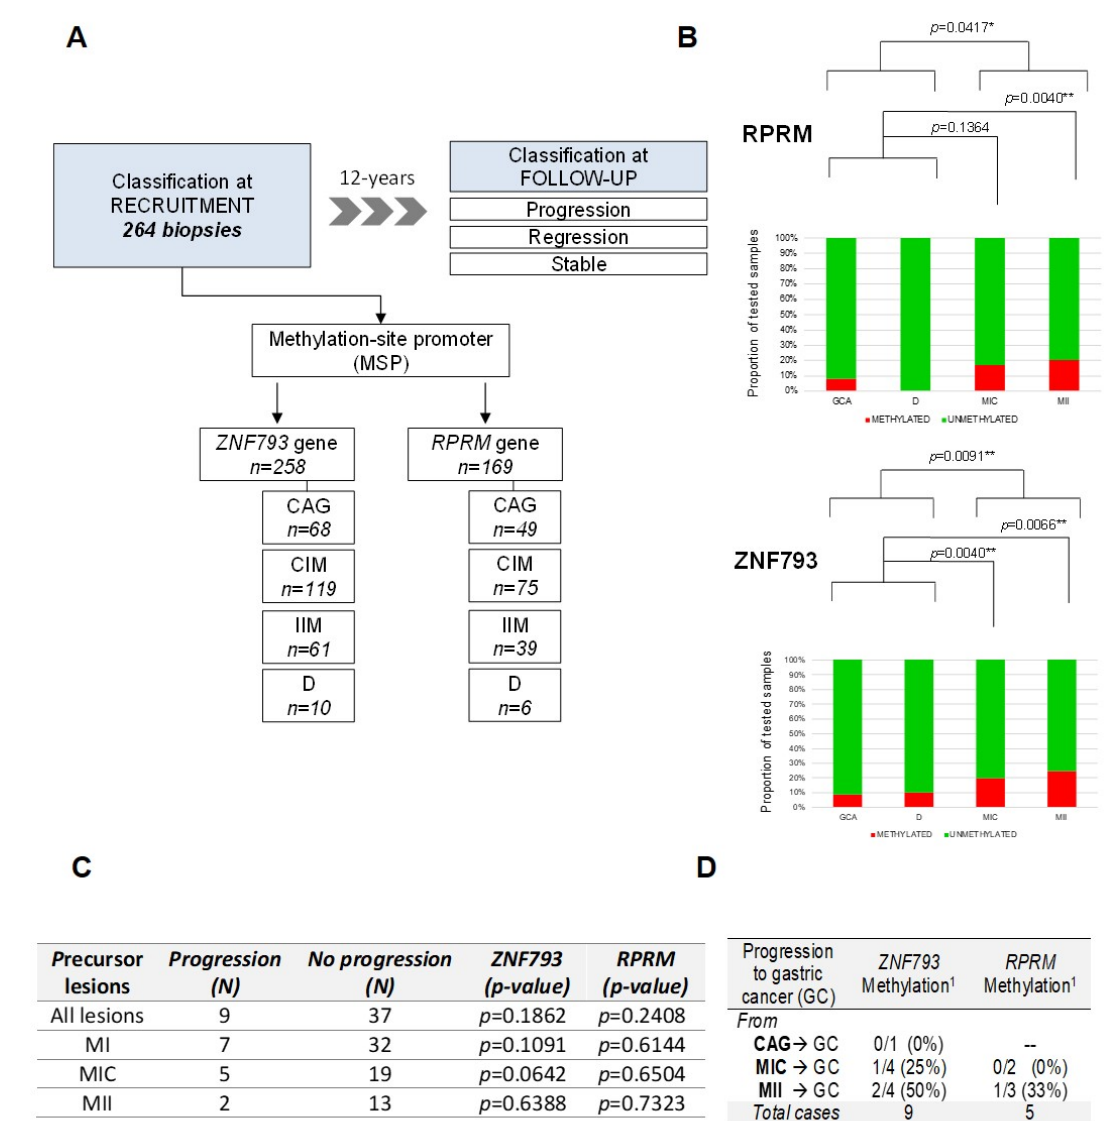
Figure 4. Methylation of ZNF793 and RPRM genes in a 12 ‐ year follow ‐ up study of gastric cancer precursor lesions. ( A ) Characteristics of the validation cohort of 264 samples corresponding to precursor lesions obtained from an observational longitudinal study. ( B ) Methylation events for ZNF793 ( up ) and RPRM ( down ) genes in precursor lesions. (* p ‐ value ≤ 0.05, ** p ‐ value ≤ 0.01) ( C ) Association analysis between the progression in the cascade of gastric precursor lesions and the methylation of ZNF793 and RPRM genes. The p ‐ values are obtained from Fisher’s exact test. ( D ) Number of cases of progression to gastric cancer, after a 12 ‐ year follow ‐ up, for gastric precursor lesions. Methylation state of ZNF793 and RPRM promoters at the recruitment biopsy are indicated. CAG, multifocal chronic atrophic gastritis; CG, gastric cancer; D, dysplasia; IM, intestinal metaplasia; NAG, non ‐ atrophic gastritis; NM, normal mucosa.